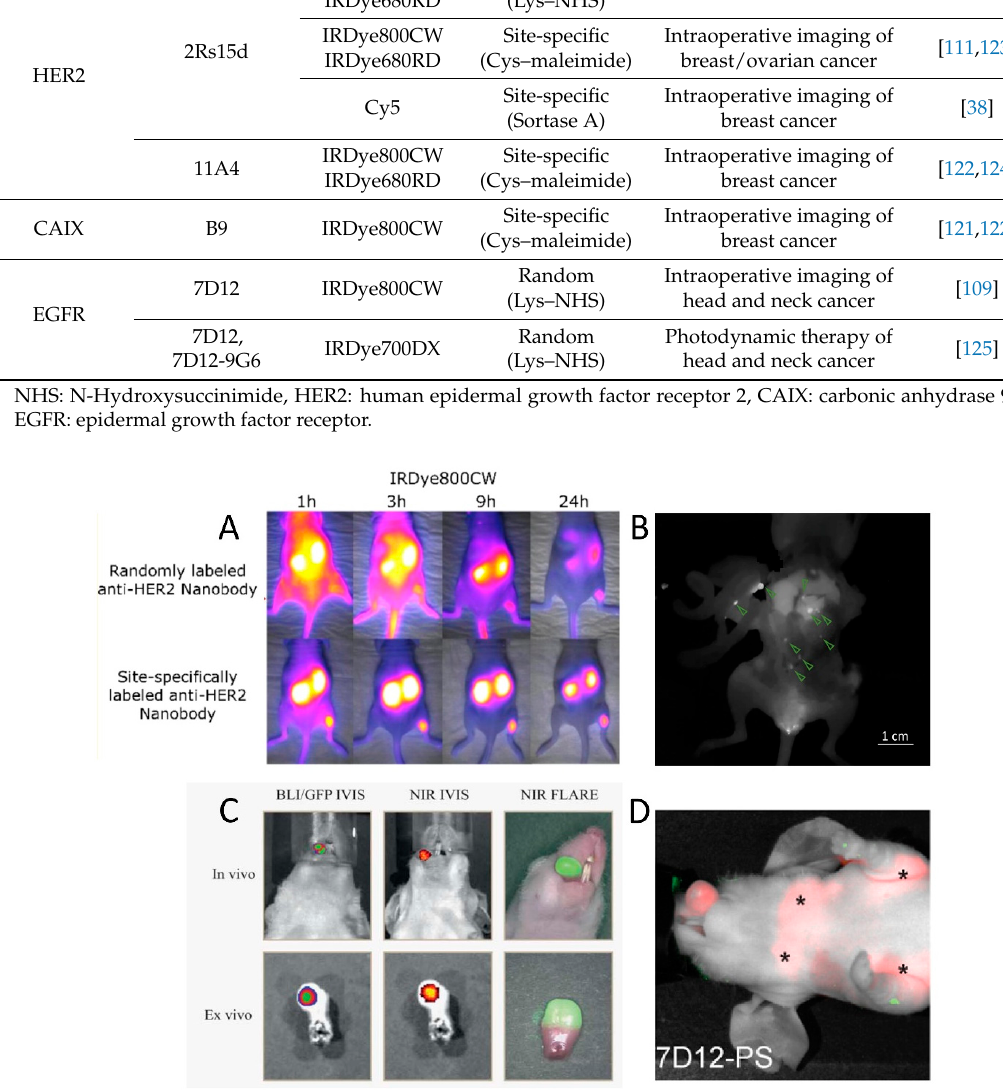
Figure 2. Examples of in vivo fluorescent molecular imaging with nanobody tracers in mouse tumor models. ( A ) Comparison of the biodistribution and tumor-targeting potential of the anti-HER2 nanobody 2Rs15d conjugated with IRDye800CW either randomly (top) or site-specifically (bottom). Adapted with permission from [111]. Copyright 2017 American Chemical Society. ( B ) Fluorescence image acquired during the surgical resection of intraperitoneally disseminated HER2+ tumor lesions. Site-specifically IRDye800CW-labeled 2Rs15d nanobody was injected 90 min before surgery. Fluorescent signal in tumor lesions (indicated by green arrows) is clearly discernible from background signal. Adapted with permission from [123]. ( C ) Real-time fluorescence imaging of orthotopic tongue